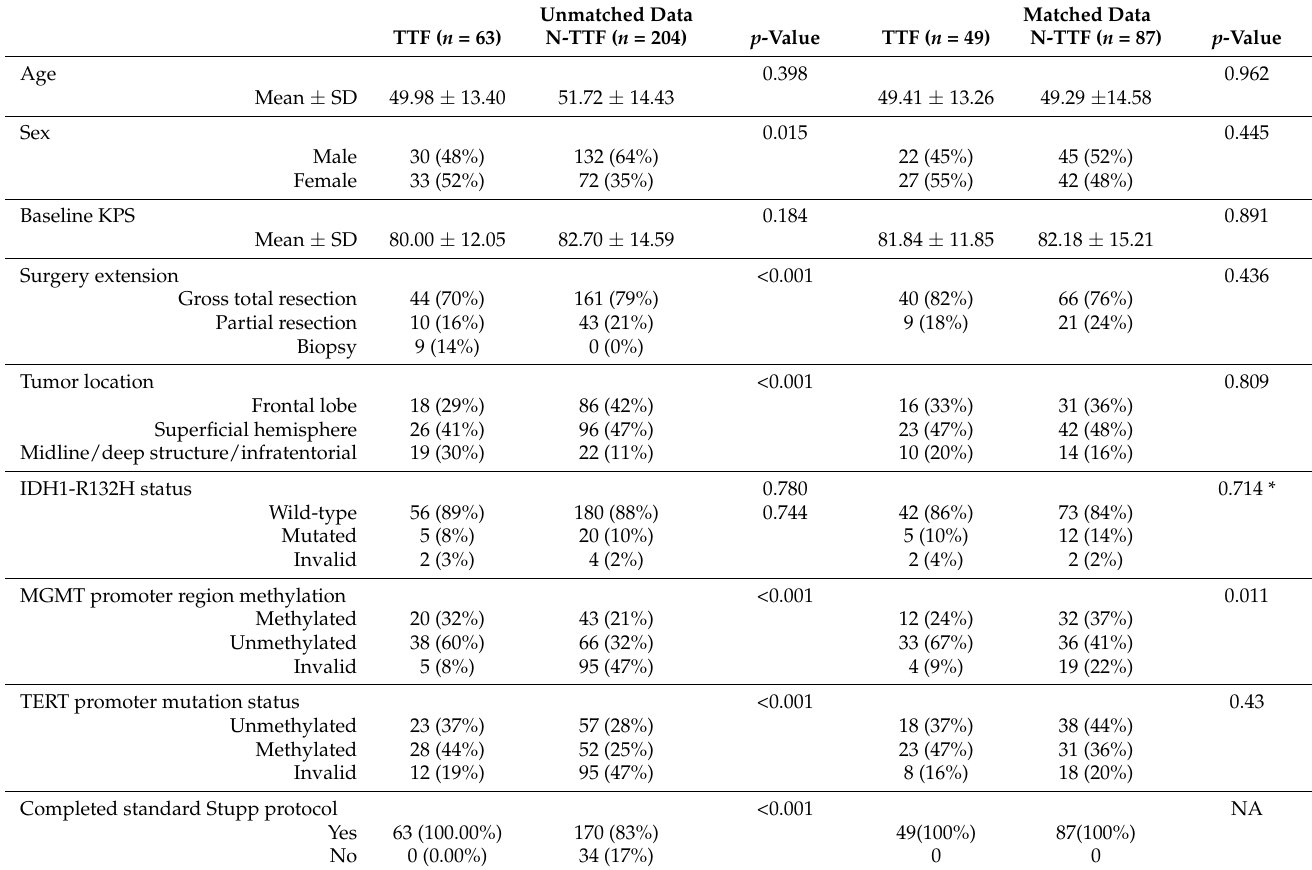
Table 4. Patient characteristics before and after propensity score-matching